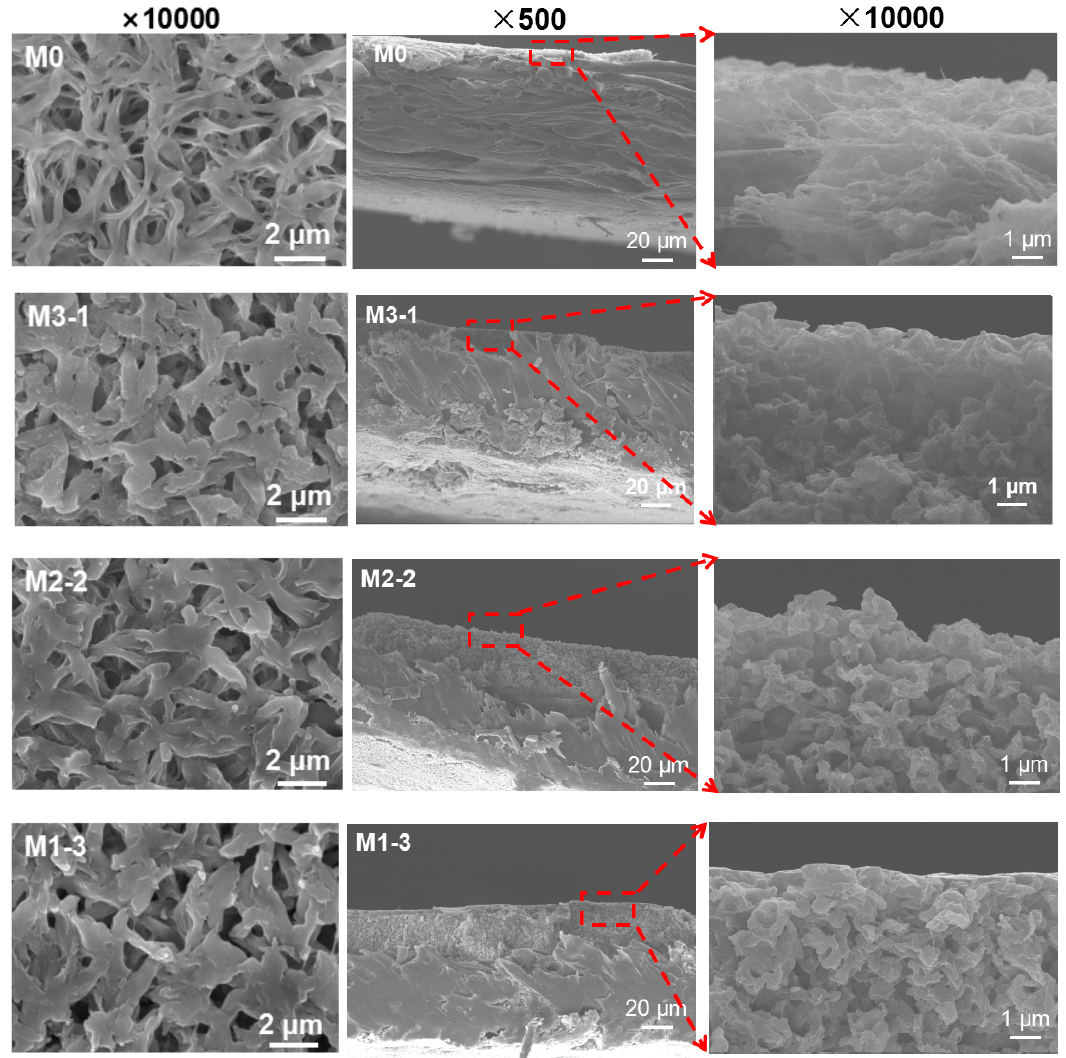
Figure 4. SEM images of membrane surface (left, ×10,000) and cross section (middle, ×500, and right, ×10,000) for M0, M3-1, M2-2, M1-3.